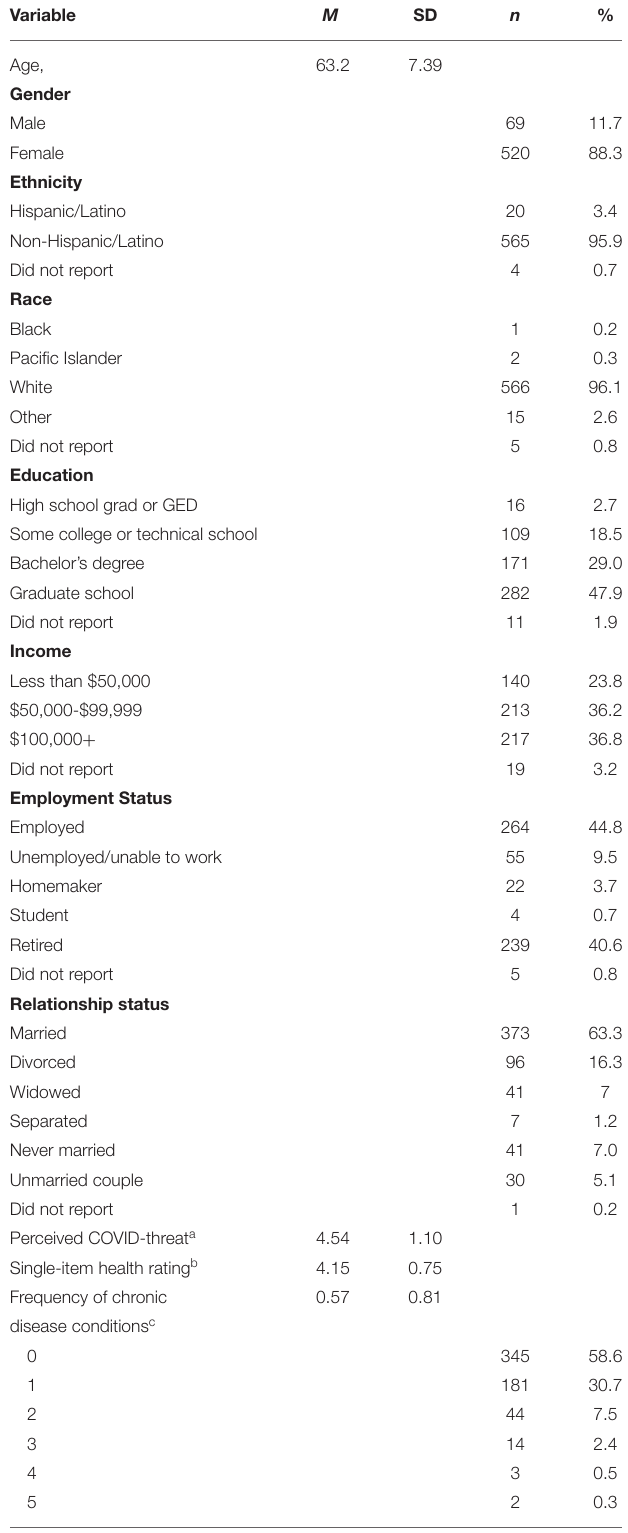
TABLE 1 | Participant ( N = 589) demographic characteristics and descriptive outcomes for perceived COVID-19 threat, health status, and chronic disease